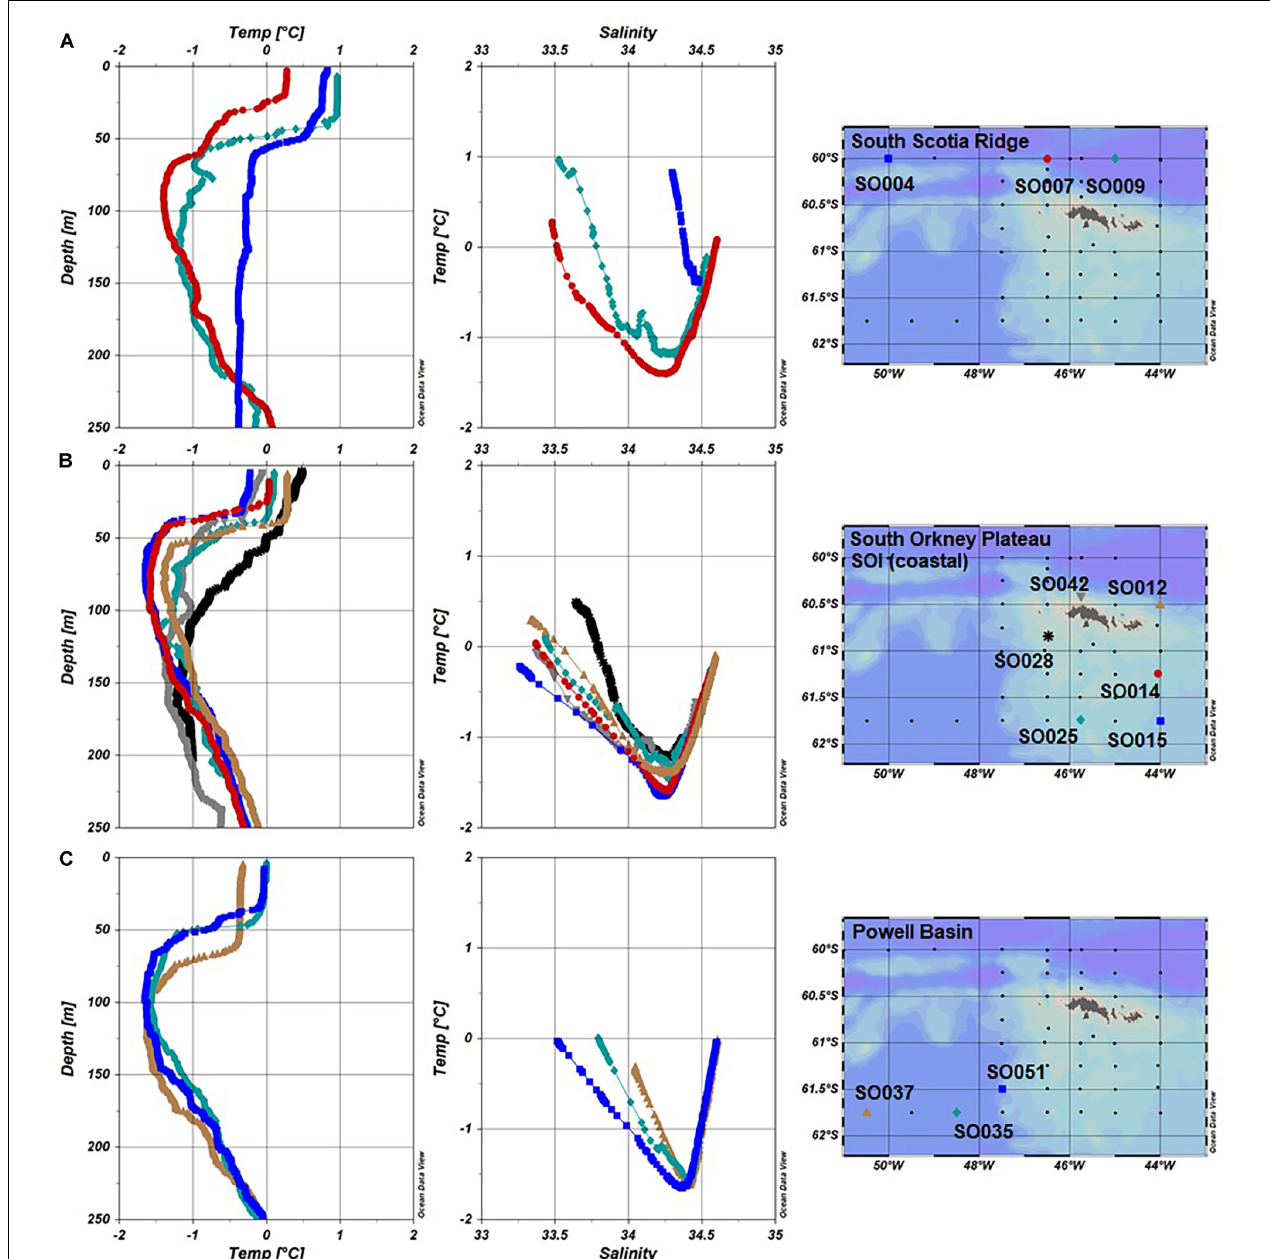
FIGURE 5 | Water type (T/S profiles) and temperature depth profiles for Fe stations in the SOI 2008 divided in groups. (A) South Scotia Ridge (SO004, SO007, and SO009), (B) South Orkney Plateau (SO012, SO0014, SO015, and SO025), and (C) Powell Basin (SO035, SO037, and SO051) and South Orkney Islands-Coastal (SO028 and